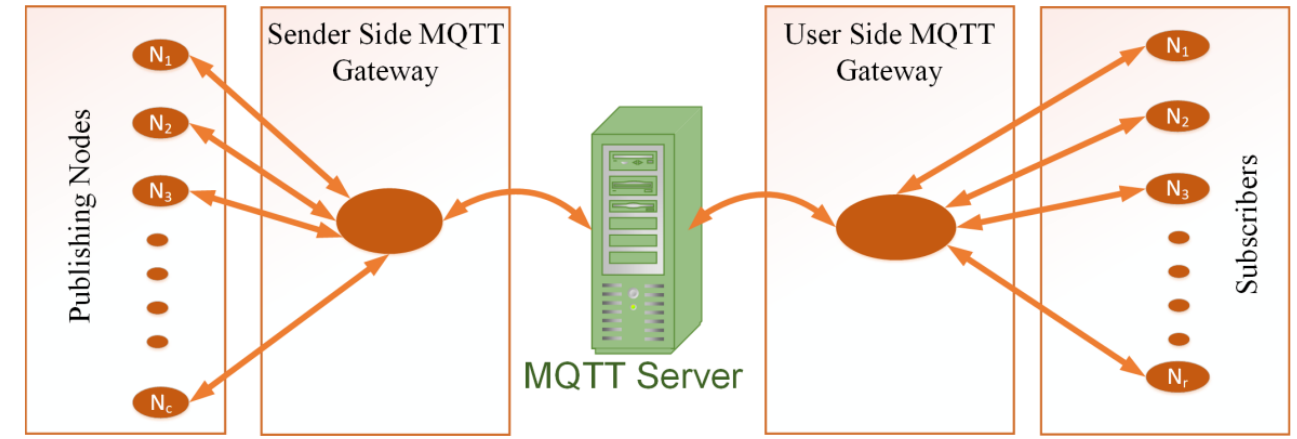
Figure 4. System Model and connectivity.